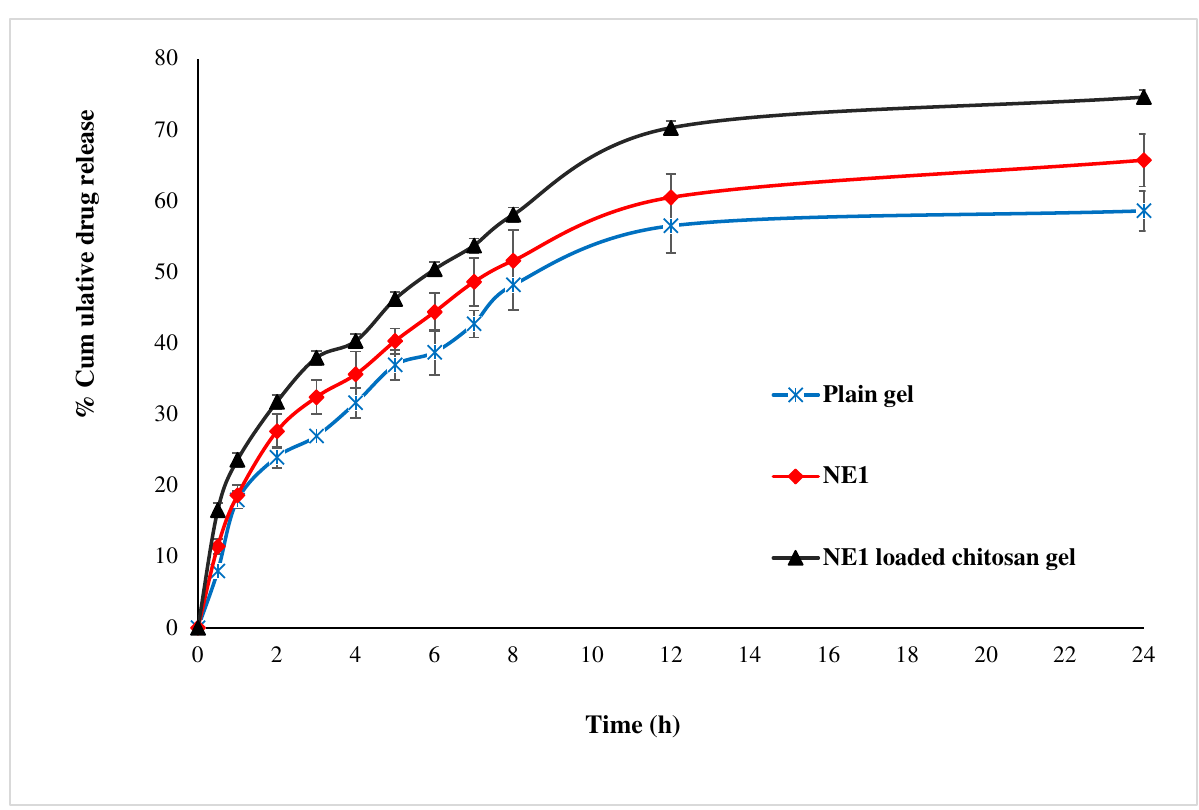
Figure 5. Release profile of optimized NEs (CRB-NE1), the plain gel, and the CRB-NE1-loaded chi- tosan gel.